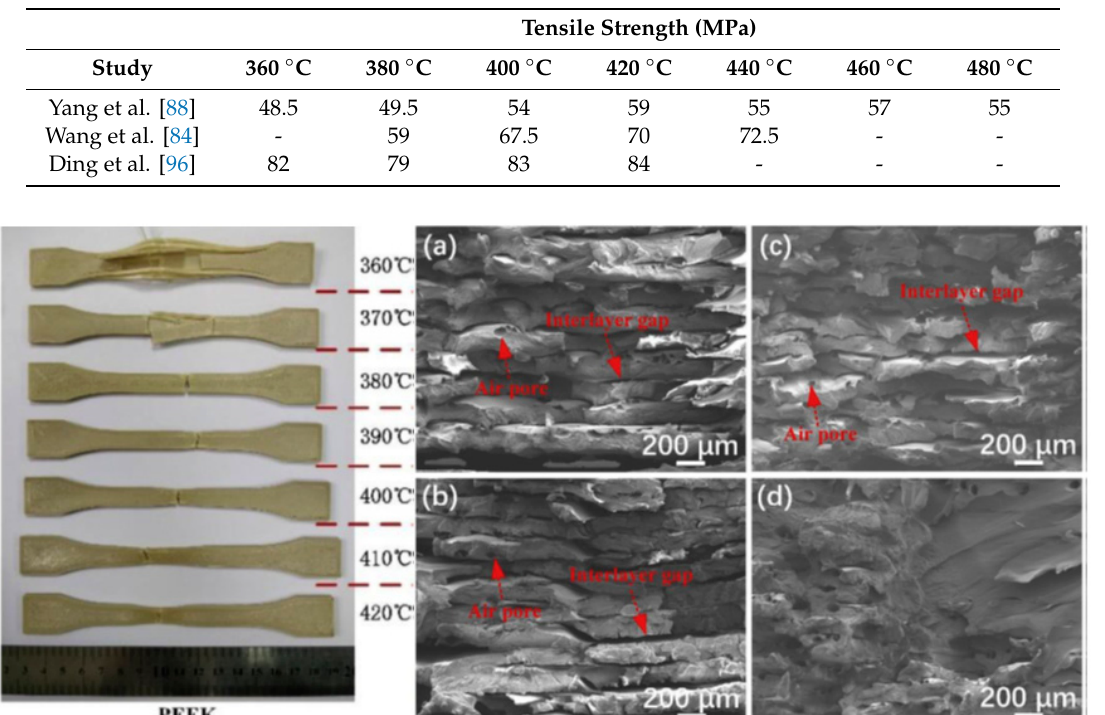
Table 5. Tensile strength of PEEK at different nozzle temperatures.